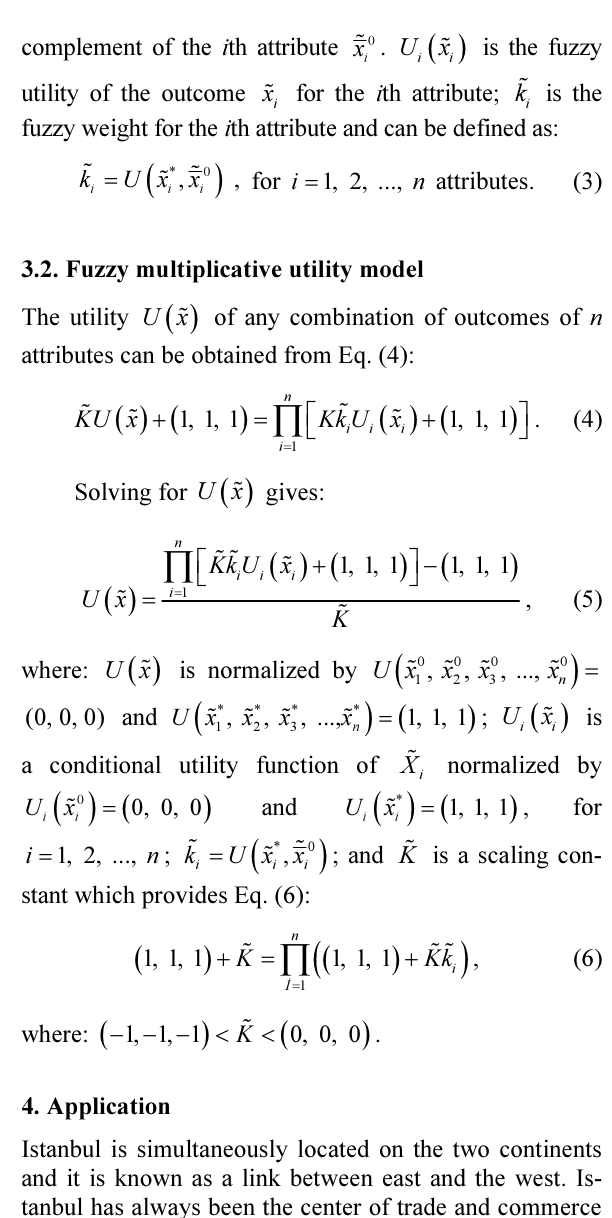
Fig. 1. Illustration of the question to determine the scaling factor i k